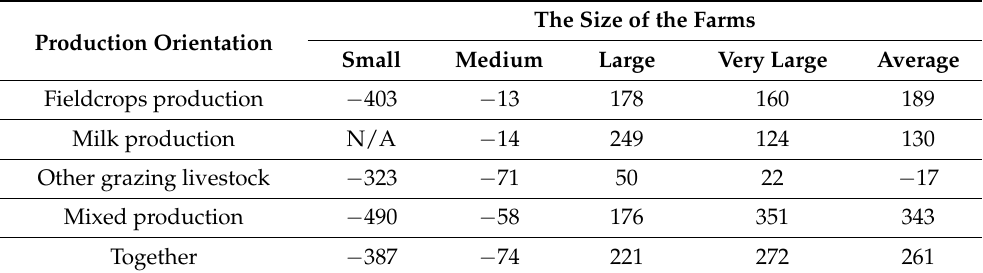
Table 11. Profit (loss) per UAA (2015–2020 average); (in EUR/ha). Production